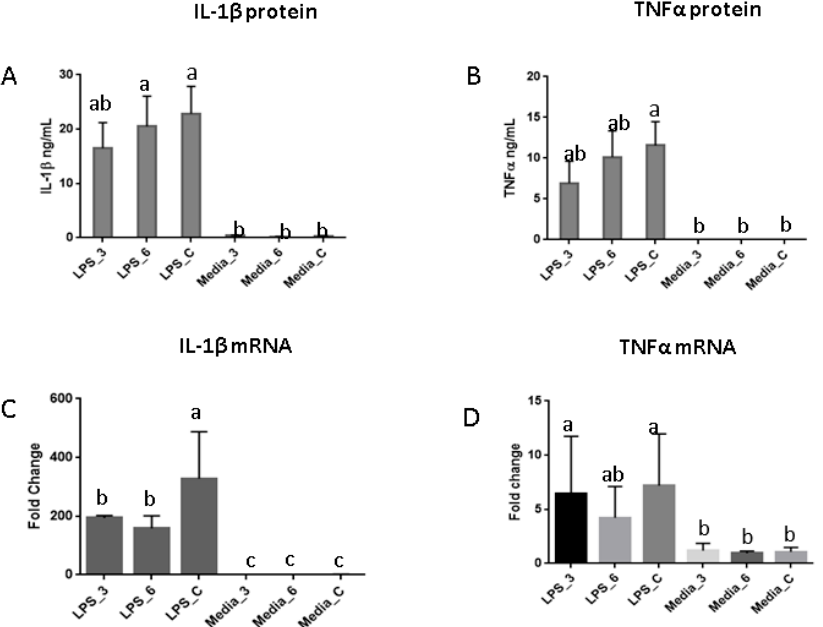
Figure 2. LPS-induced Interleukin 1 beta (IL-1 β ) and Tumor necrosis factor alpha (TNF α ) in cultured alveolar macrophages (AM) .( A , B ) Bar plots representing IL-1 β and TNF α protein produced by AM derived from pigs fed three servings, six servings or non-supplemented control diets and cultured with 5% porcine serum-complete media with Salmonella typhimurium LPS (10 ng/mL) (three bars on the left) or complete media without LPS (three bars on the right). ( C , D ) Gene expression for IL-1 β and TNF α mRNA in AM measured by Real time-Polymerase Chain Reaction (RT-PCR). Bars represent a fold change of mean difference among dietary groups. Means with different superscripts are significantly different ( p < 0.05).